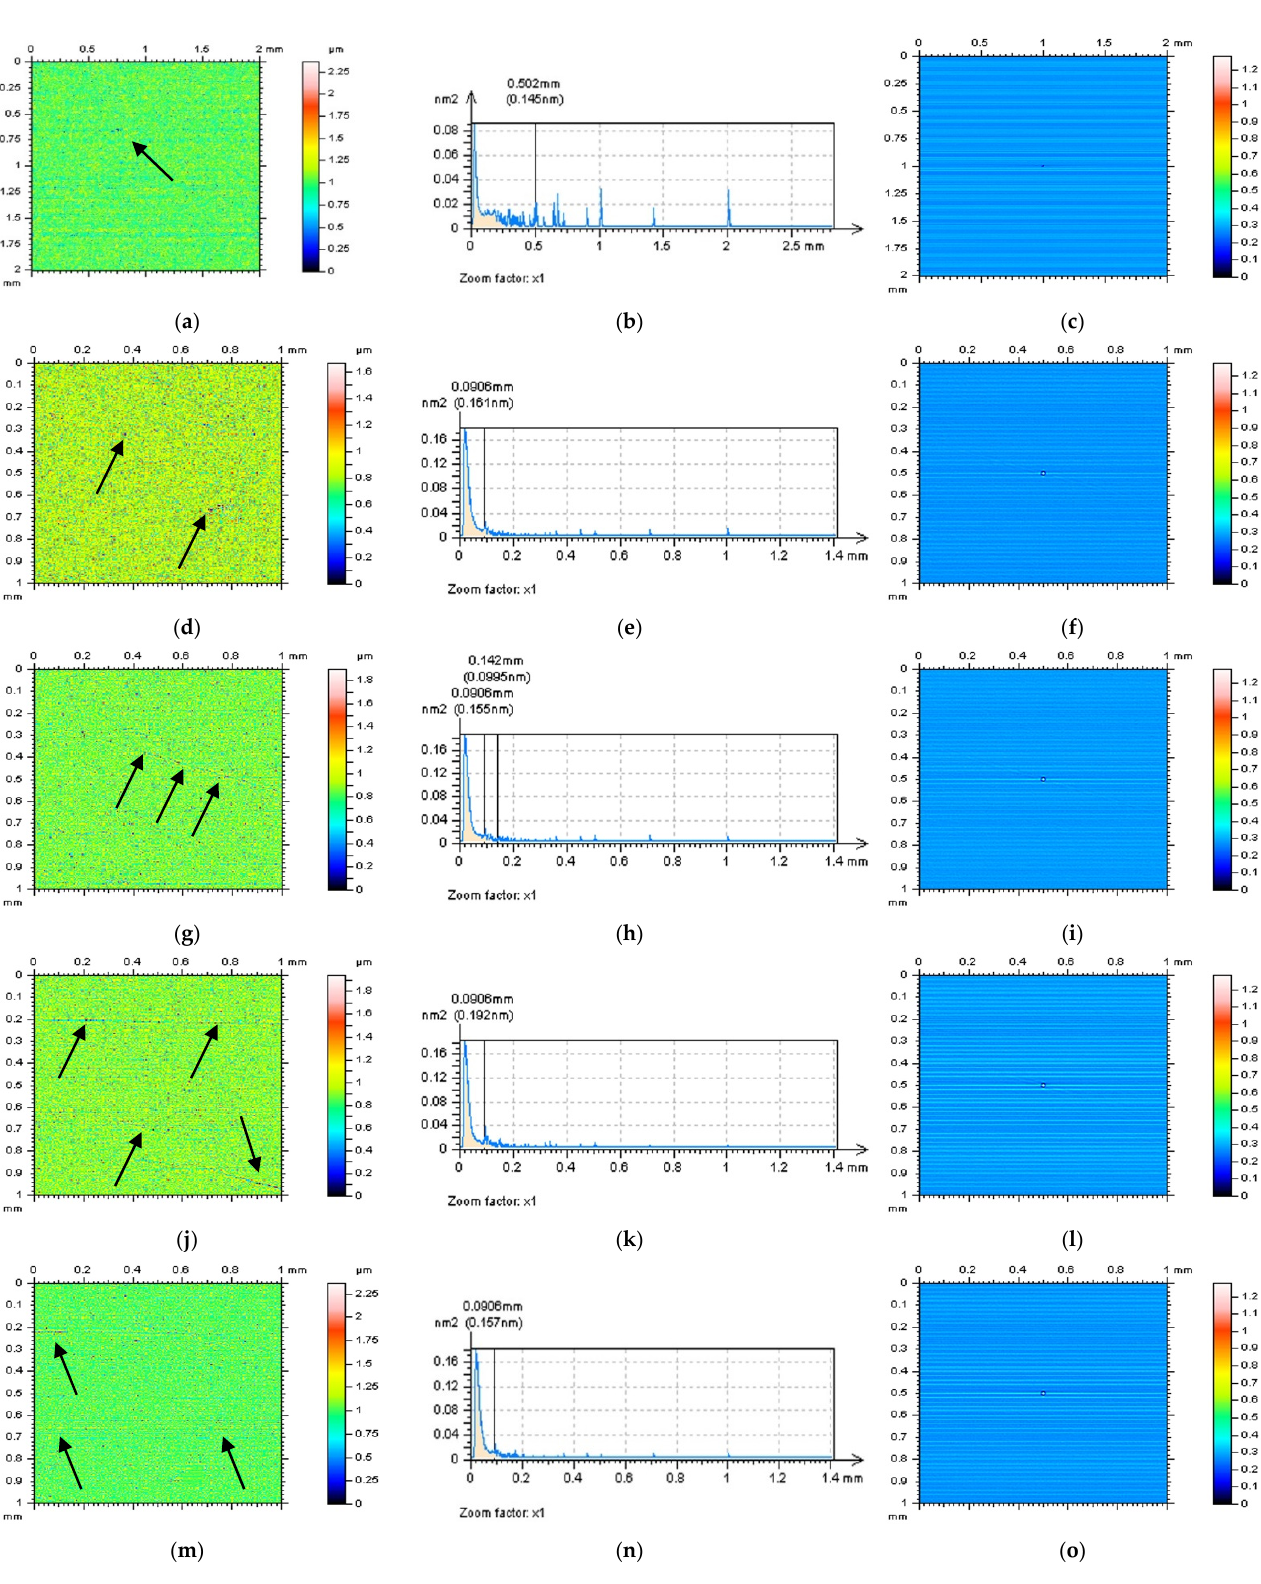
Figure 7. Contour map plots (left column), its 3D PSDs (middle) and ACFs (right column) of NS received by an SF filter application (cut-off = 0.015 mm) from the measured surface ( a – c ) and surfaces: E ( d – f ), F ( g – i ), G ( j – l ), and H ( m – o ) extracted from a turned topography. The non-noise features were indicated by arrows.